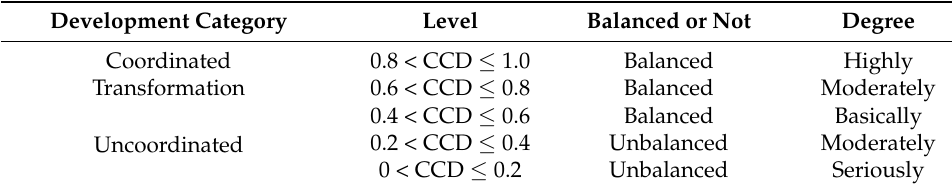
Table 2. Levels of